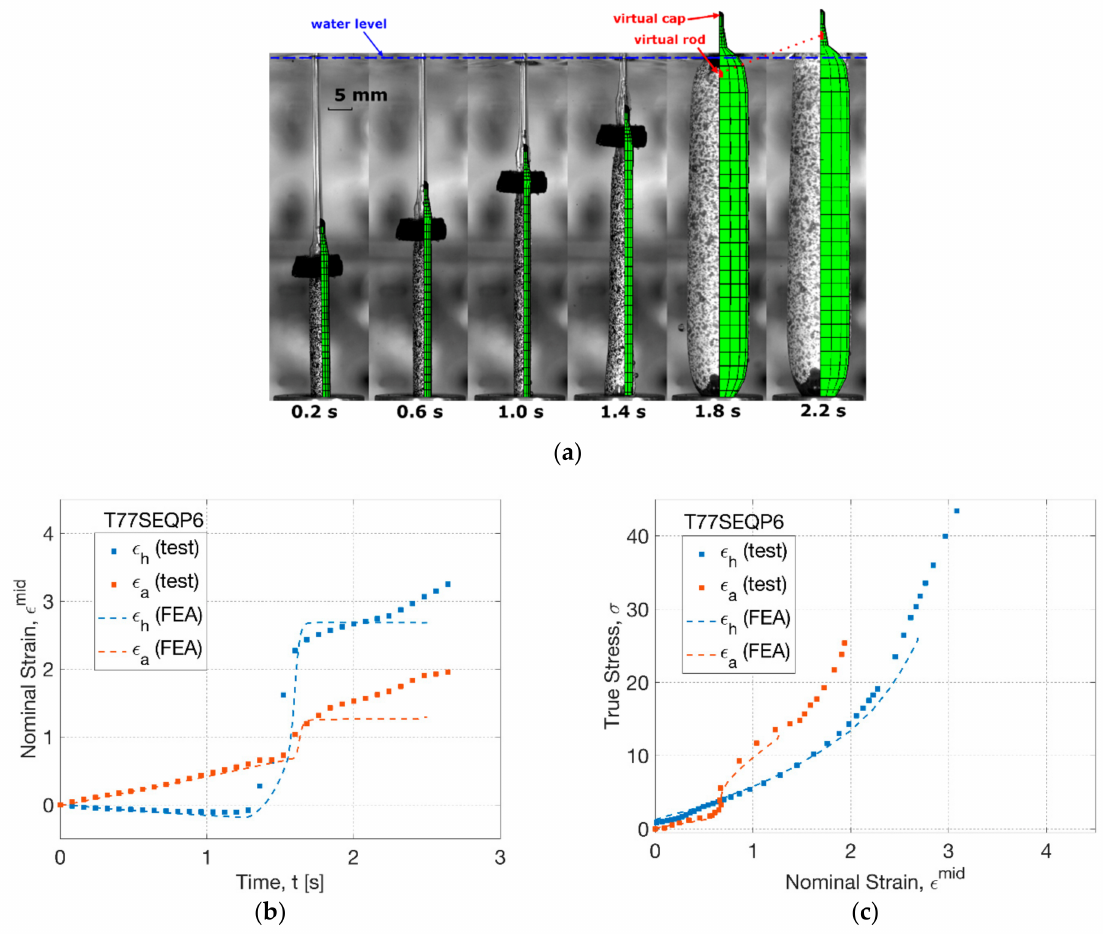
Figure 13. Comparison of results from FEA simulation and blowing test (T77SEQP6): ( a ) shape evolution, ( b ) strain history, ( c ) stress–strain